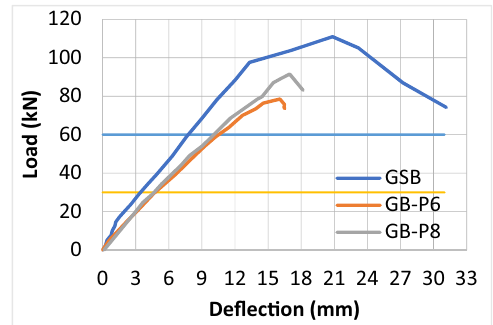
Figure 6: Load – de fl ection curves of Group B.